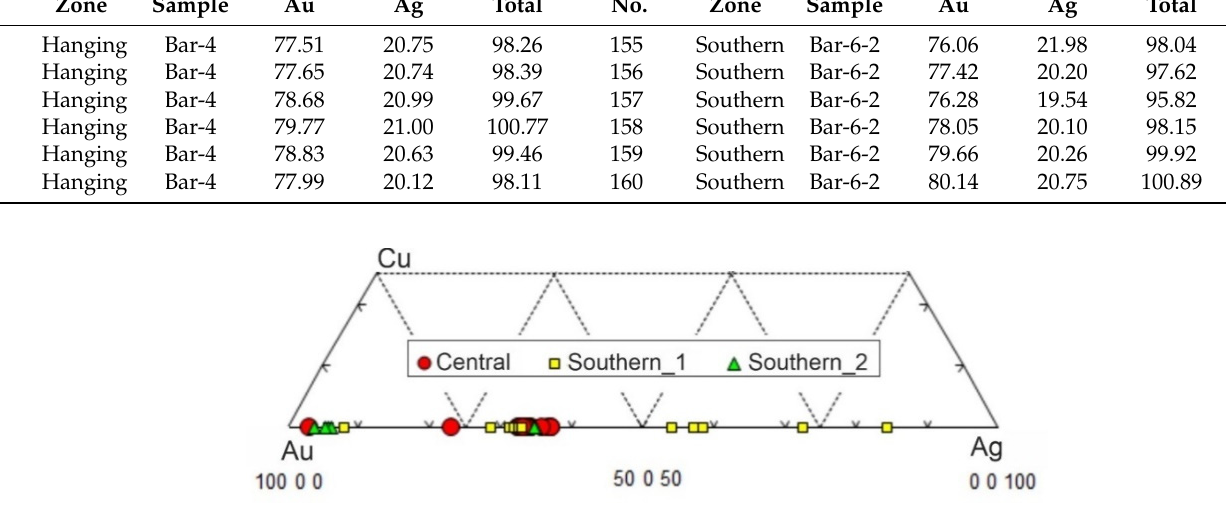
Figure 7. Variations in the composition of Au-Ag solid solutions from argillaceous-ocher sediments under mineralized outcrops of the Central and Southern zones. Southern _1 (samples BAR-6-2)— from sediments below quartz veins; Southern_2 (samples BAR-6-4)—under outcrops of oxidized ores (data from Table 3). Table 3. Composition of Au-Ag solid solutions from argillaceous-ocher rocks underneath outcrops, wt.